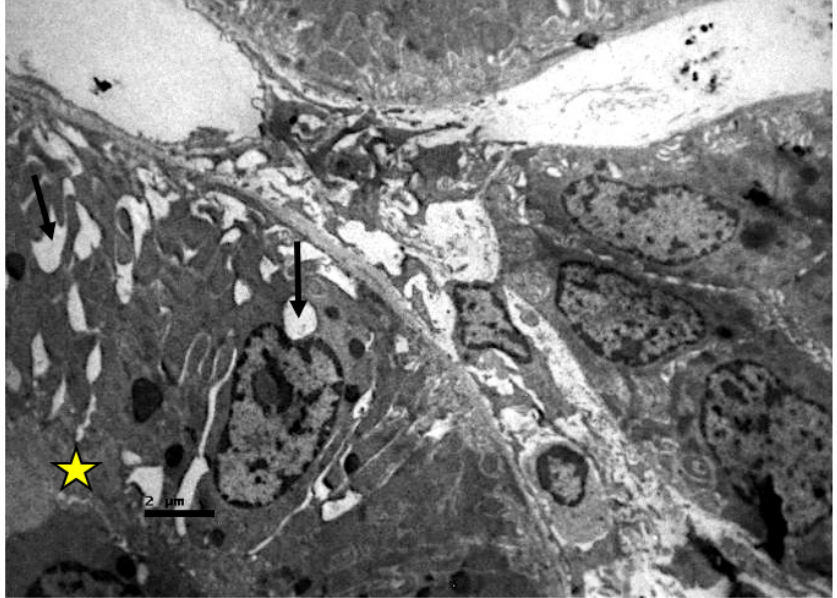
Figure 6. Proximal convoluted renal tubules of resuscitated swine sample. Vacuoles (black arrow) are observed in and between the epithelial cells, which also show absence of microvilli, on their surface (yellow star).